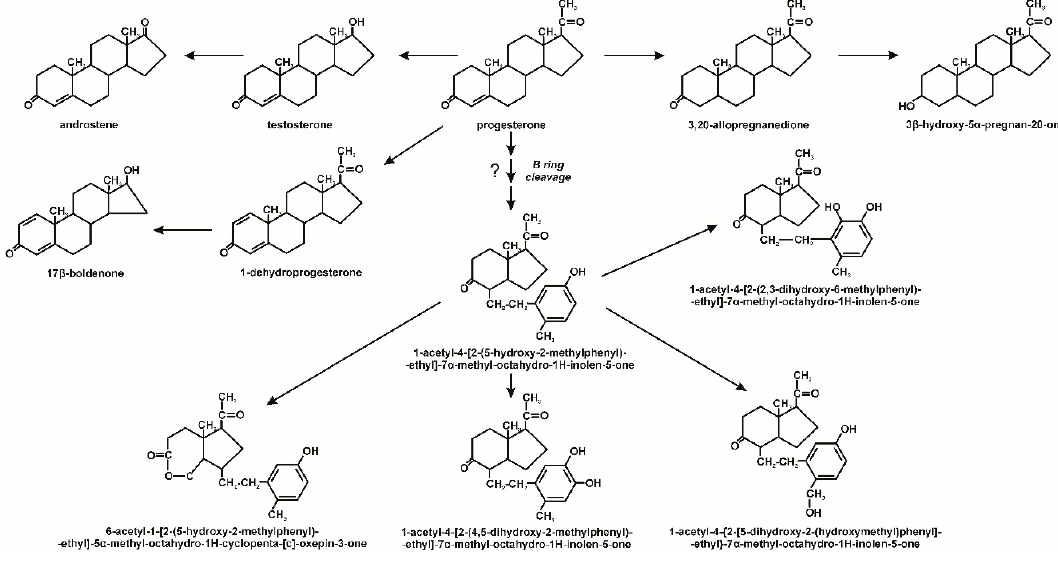
Figure 5. Proposed progesterone biotransformation by algae [55].